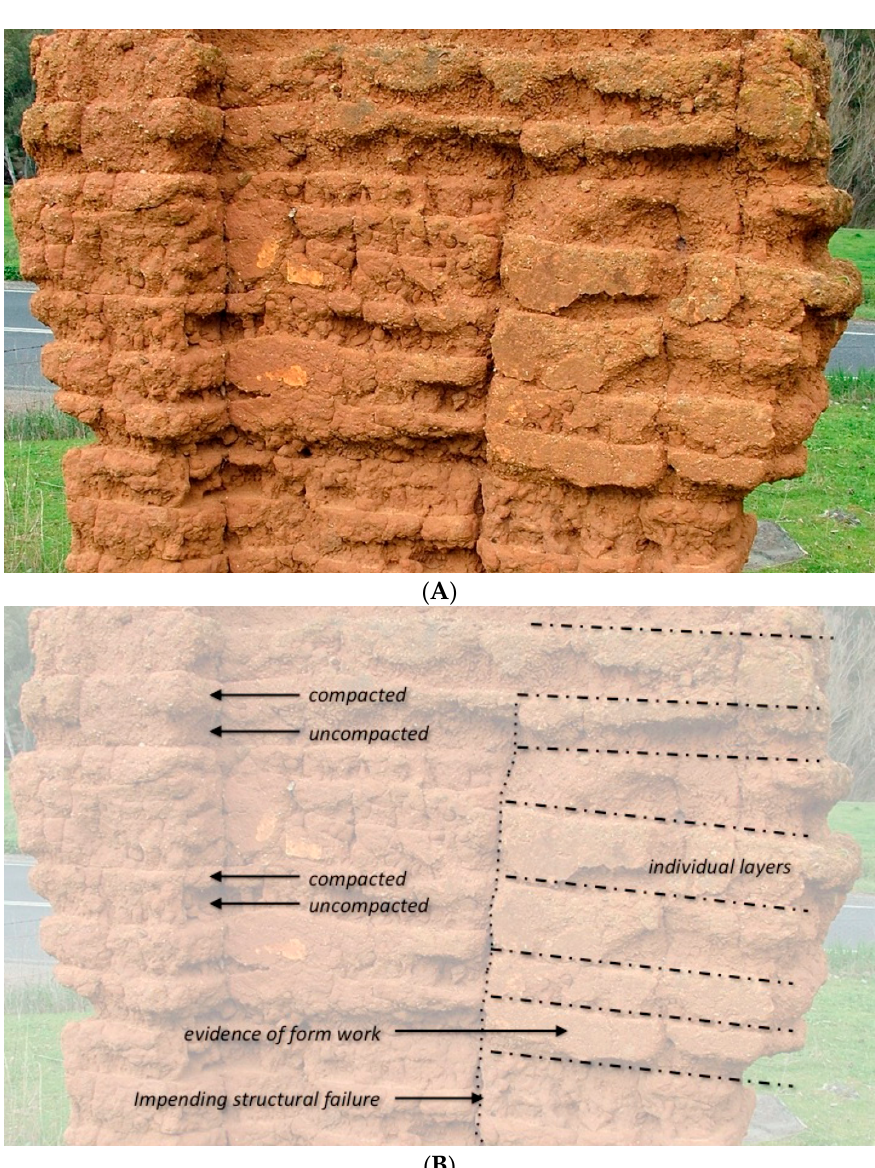
Figure 1. Influences of construction technique and quality of work on the preservation of pisé walls of a nineteenth-century ruin at Jugiong (NSW). ( A ) Photograph of a section of the northern face of the now collapsed southeastern wall block, as seen on 30 September 2005. The layers of fill and compaction are well evident. ( B ) Annotated interpretation of the image. Reprinted from Ref. [9] .